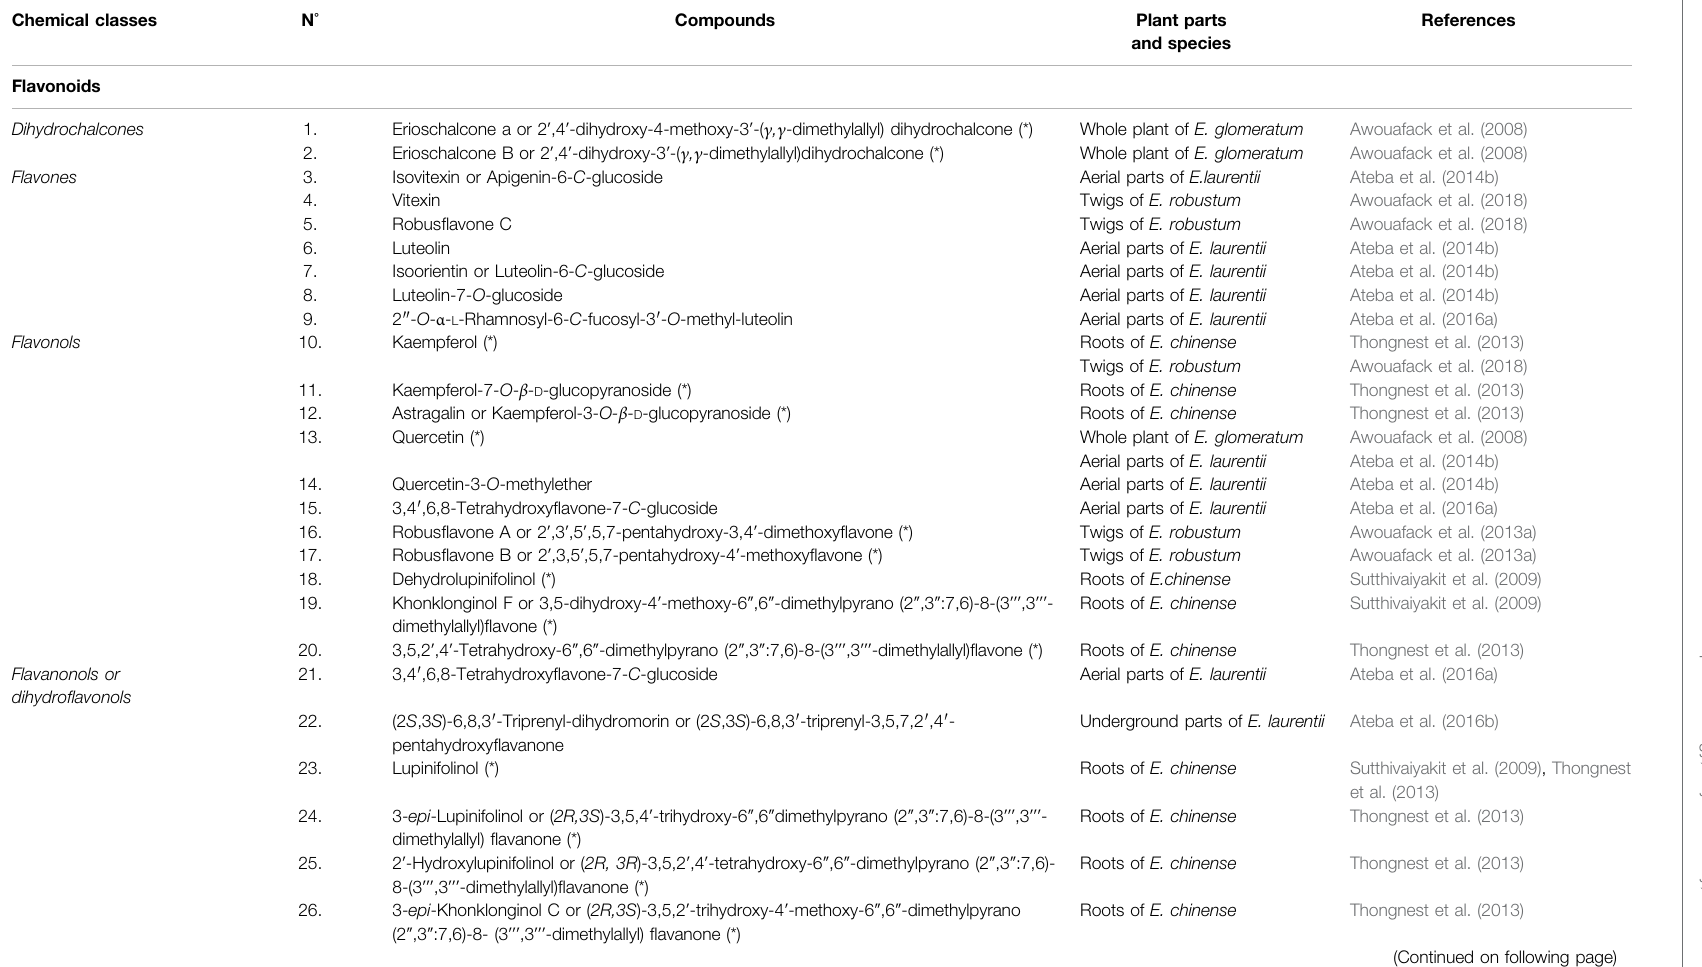
TABLE 3 | Compounds isolated/identi fi ed from Eriosema species (the structure of compounds illustrated in Figure 2 ). Chemical